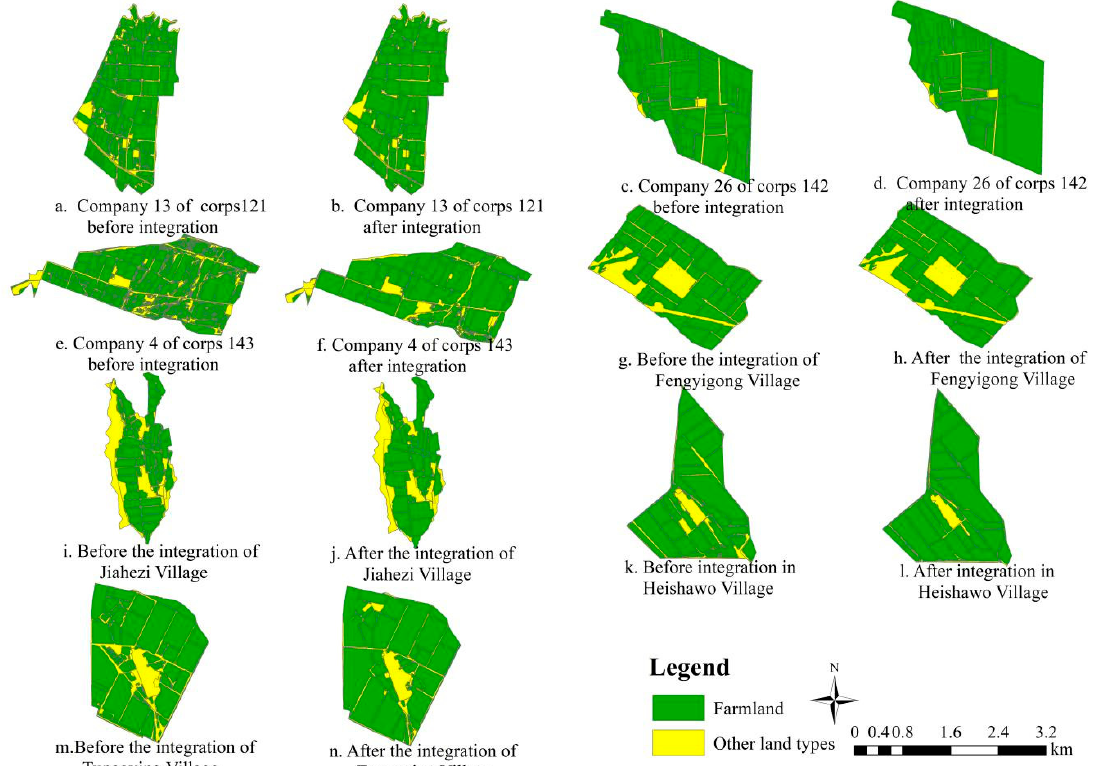
Figure 6. Comparison of seven village teams before and after land integration.